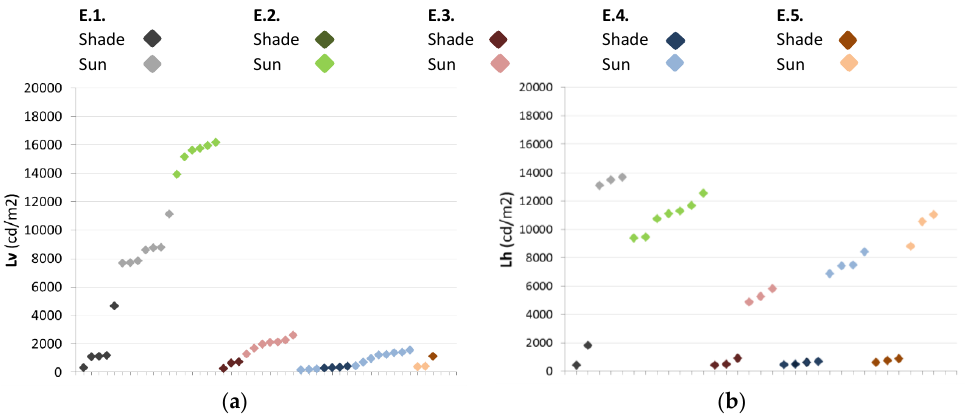
Figure 3. ( a ) Street points’ luminance (cd/m 2 ) in Zone 2; and ( b ) street points’ luminance (cd/m 2 ) in Zone 1 for Cases E.1–E.5.